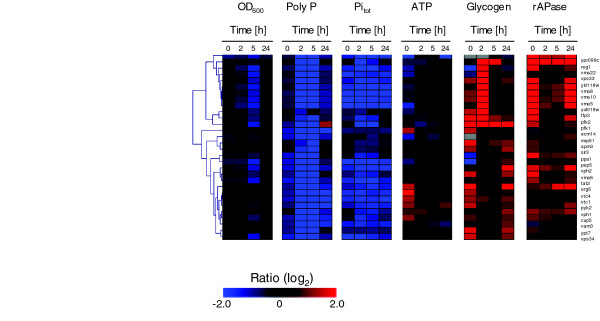
Many strains with altered poly P levels are also affected in their total phosphate content, ATP levels, rAPase activity and glycogen accumulation. All measurements (OD600, total phosphate content, ATP levels, rAPase activity and glycogen content) in the 30 strains most affected in their poly P levels are given relative to the wild type (log2-transformed). The data were hierarchically clustered (uncentered Pearson correlation, average linkage).